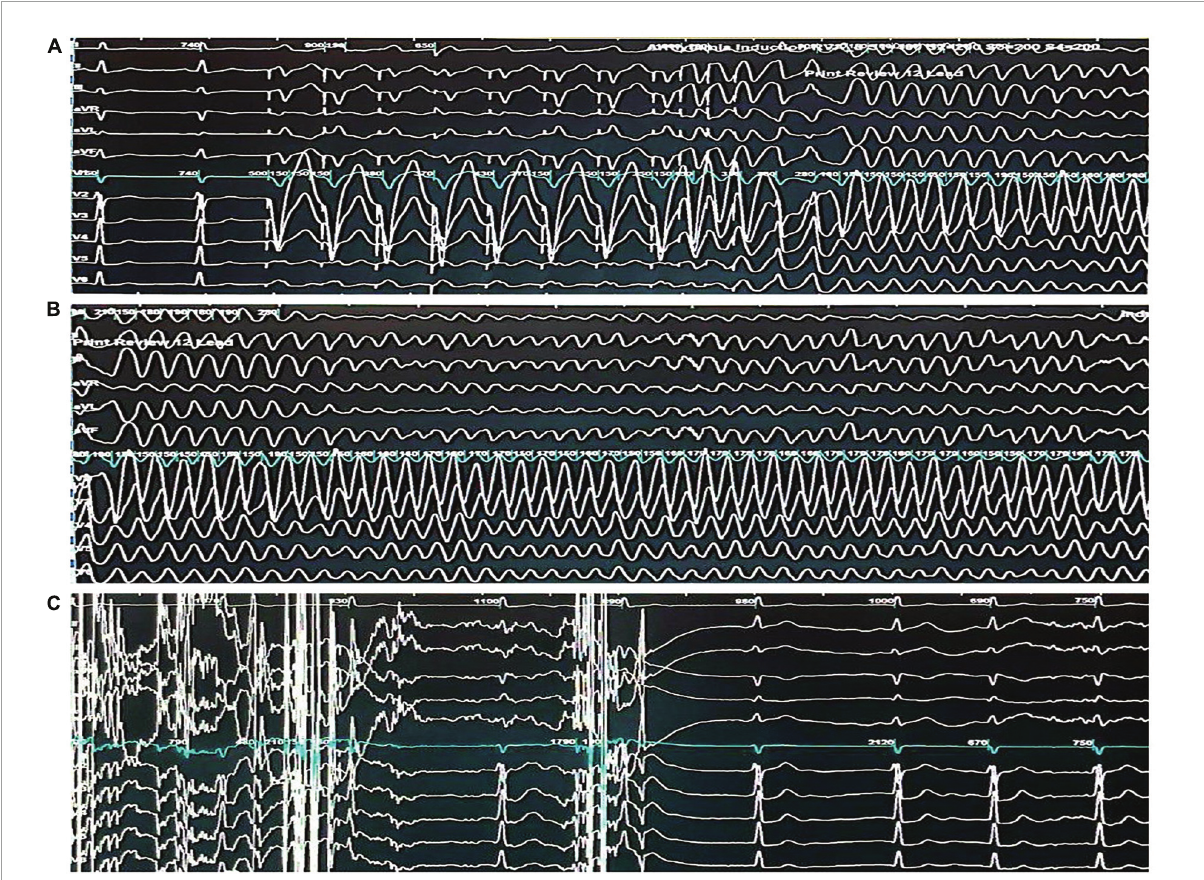
FIGURE2 Electrophysiological study demonstrating the induction and termination of ventricular fibrillation. (A) Twelve -lead electrocardiogram demonstrating the induction of ventricular fibrillation through triple extrastimuli at the right ventricular outflow tract. (B) Twelve-lead electrocardiogram demonstrating sustained ventricular fibrillation. (C) Twelve-lead electrocardiogram demonstrating the termination of ventricular fibrillation through a 360-J transthoracic direct current shock and subsequent return to sinus